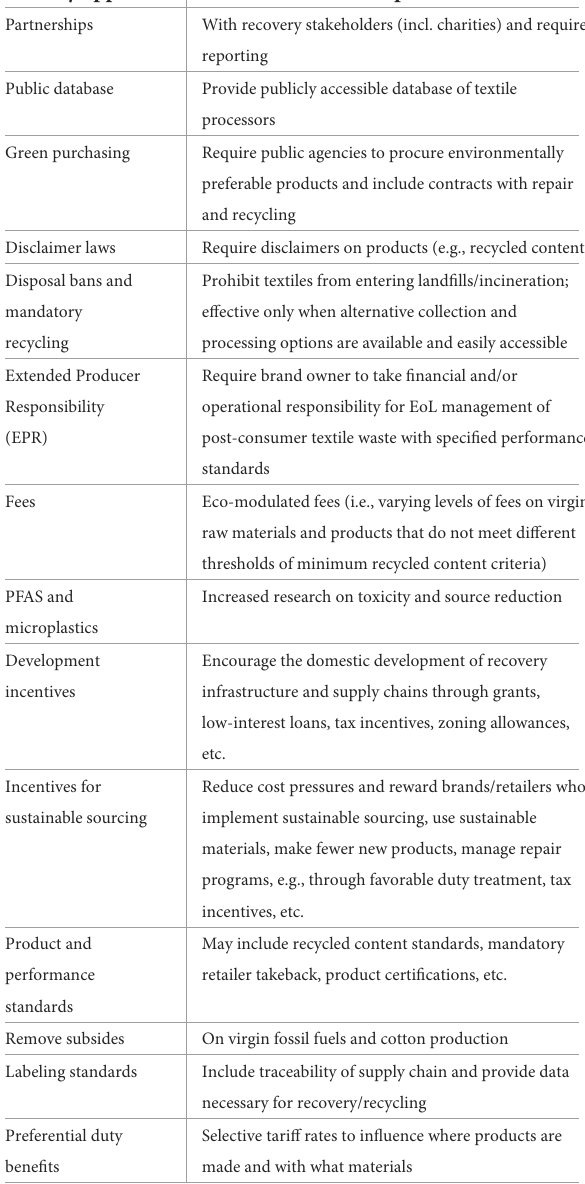
TABLE 8 Policy approaches to facilitate a circular economy for textiles at the local, state, and/or federal level [adapted from Adler (2021), Brasch (2021), Hughes